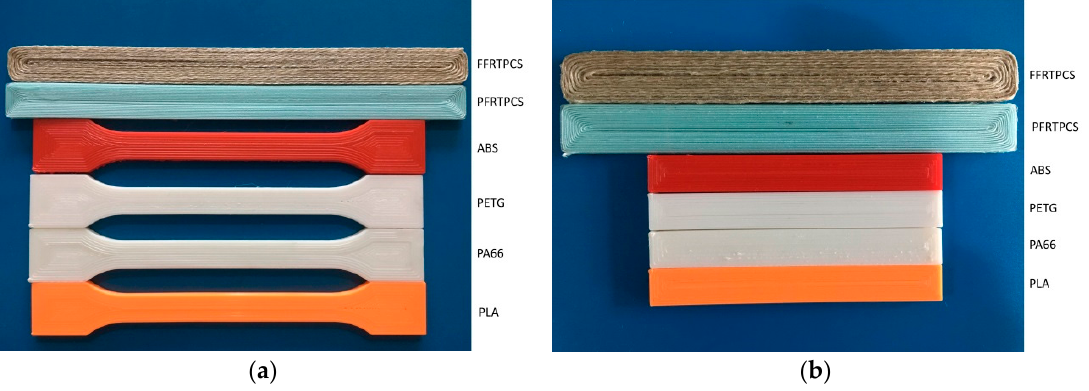
Figure 6. Printed test specimens. ( a ) Specimens for tensile test. ( b ) Specimens for flexural test.